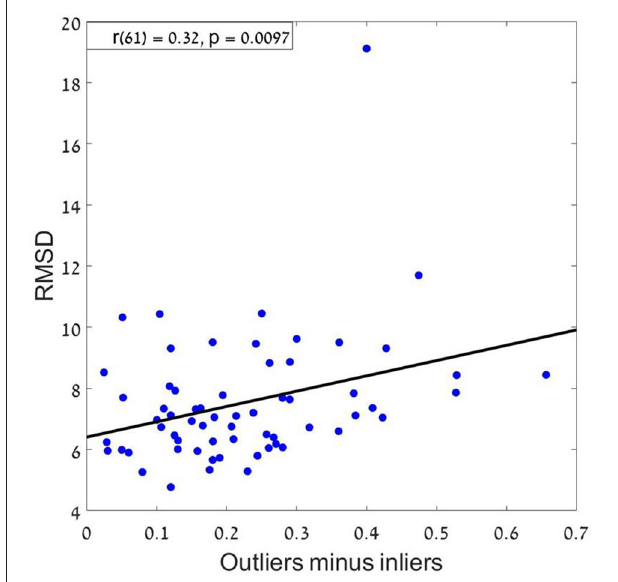
FIGURE 12 | RMSD as a function of the difference between outliers and inliers. A positive correlation means that as the difference increase (more weights to the outliers) the RMSD increases, resulting with a bigger